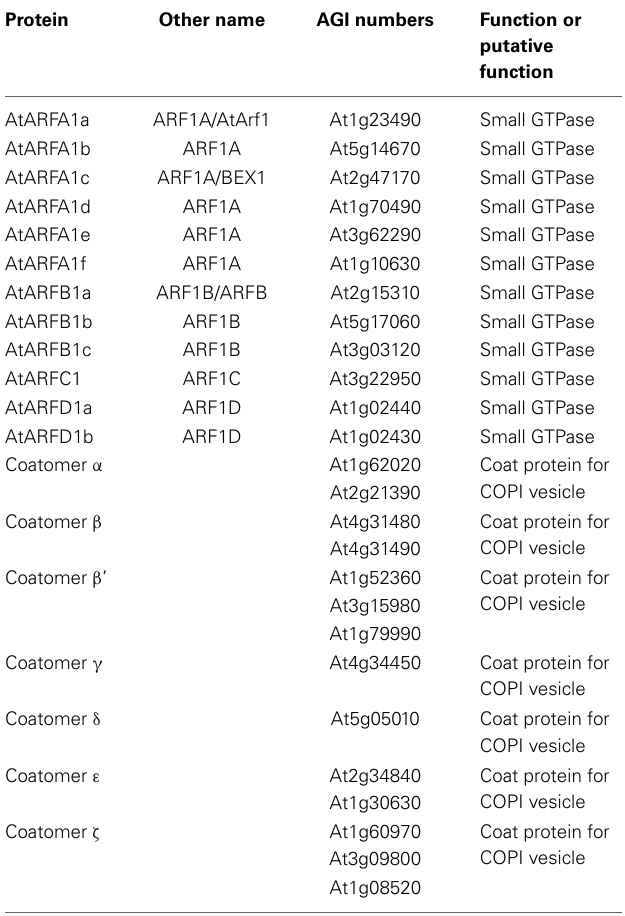
Table 2 | Arabidopsis Arf proteins and their interacting proteins.